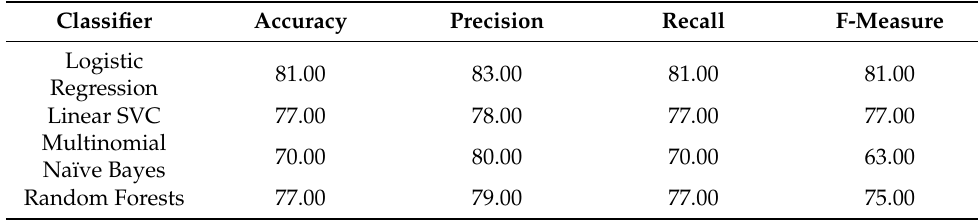
Table 11. Aspects-based sentiment analysis overall